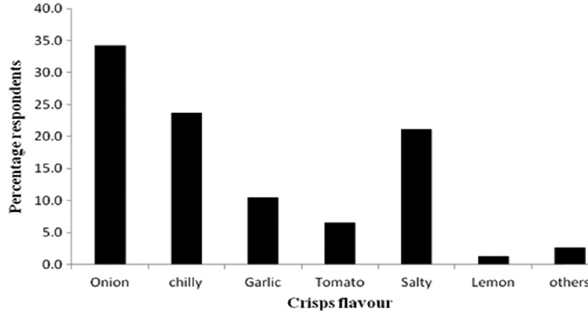
Figure 4: Percentage consumption based on the fl avor of potato